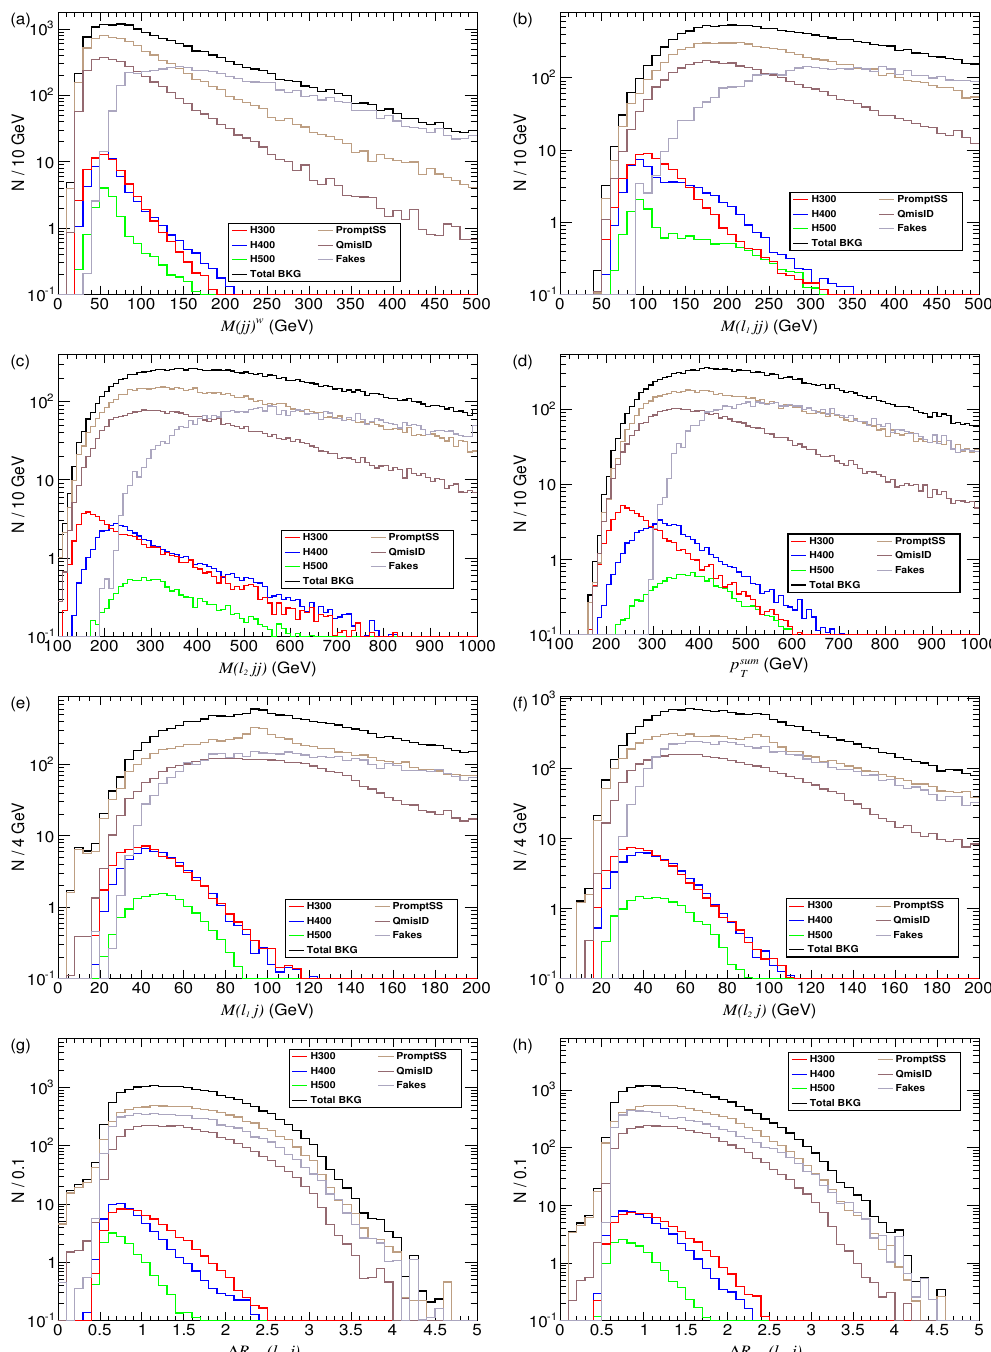
Figure 6 . Distributions of di(cid:11)erent kinematical variables in the SS2L decay channel: (a) invariant mass of the two closet jets; (b) invariant mass of the leading lepton and the two closet jets; (c) invariant mass of the sub-leading lepton and the remaining jet(s), (d) linear sum of p leptons, jets and transverse missing energy, (e) invariant mass of the leading lepton and the closet jet, (f) invariant mass of the sub-leading lepton and the closet jet, (g) minimum (cid:1) R distance between the leading lepton and jet, (h) minimum (cid:1) R distance between the sub-leading lepton and jet. For these plots, we input an integrated luminosity of 300fb (cid:0) 1 .